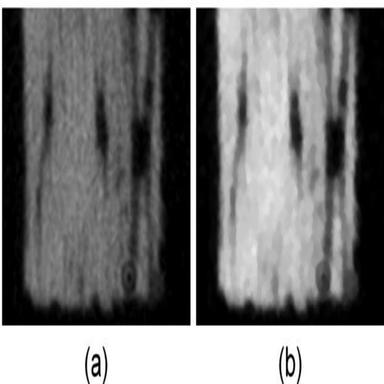
Median filter processing: (a) Original image; (b) Filtered image.